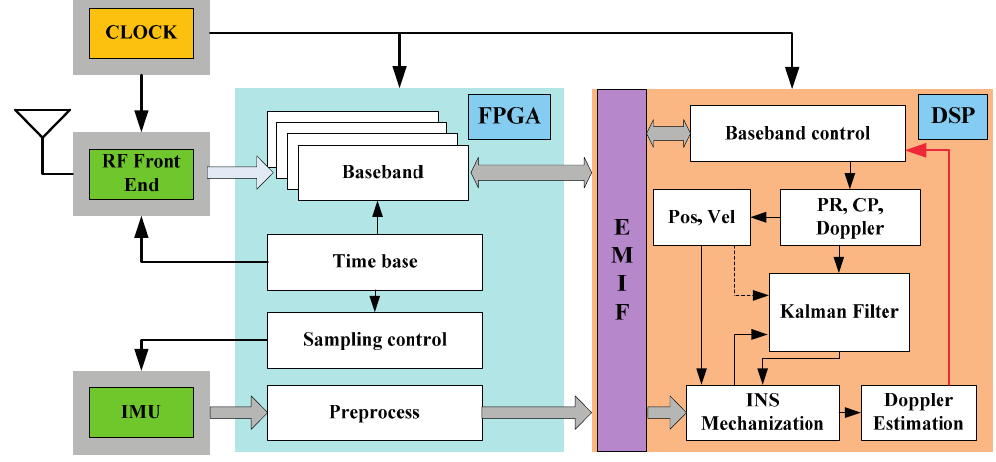
Figure 11. Integrated GNSS/INS deeply-coupled software architecture. PR represents pseudo-range, CP represents